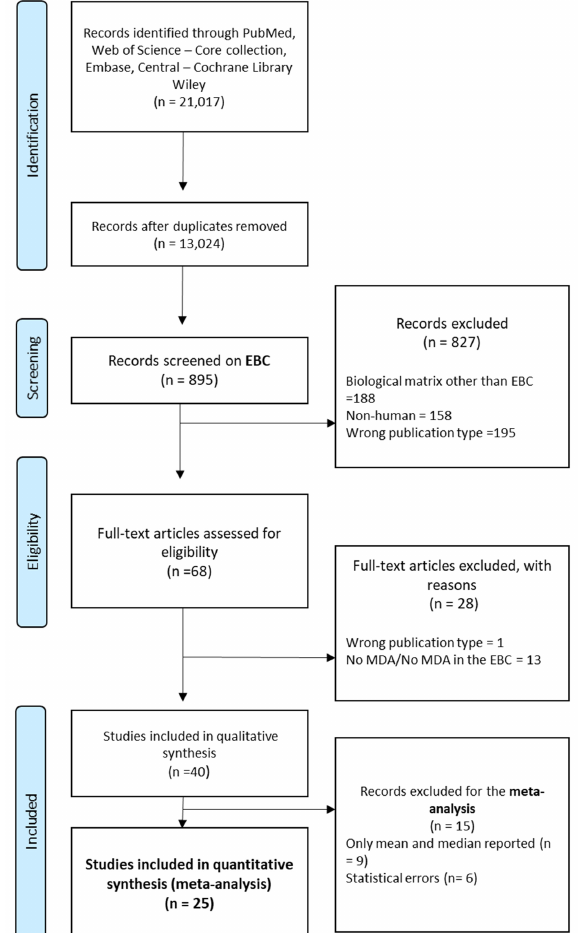
Figure 1. Flowchart of the article selection process.